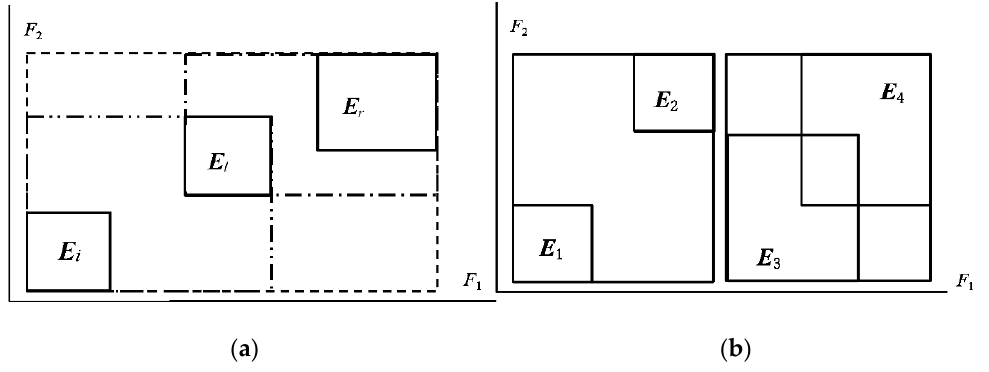
Figure 4. Examples for compactness.